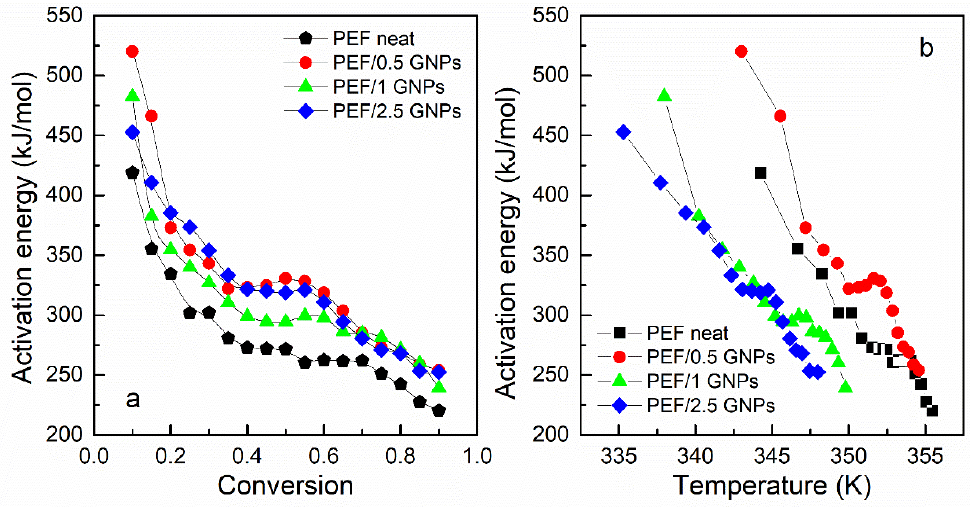
Figure 9. Activation energy of the glass transition vs. conversion ( a ) and temperature ( b ) of the neat PEF and PEF/GNP nanocomposites.